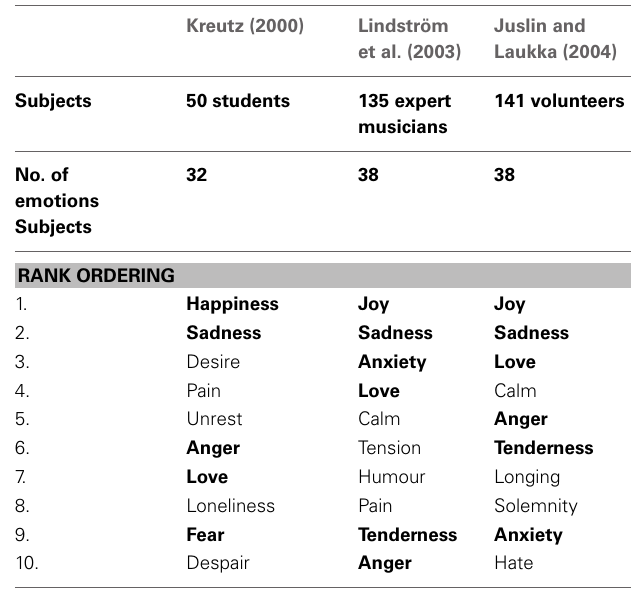
Table 1 | Ratings of the extent to which specific emotions can be expressed in music.